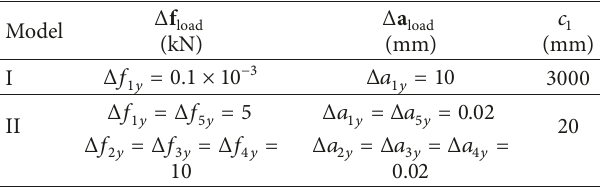
Table 1: Analysis parameters for Models I and II. Model